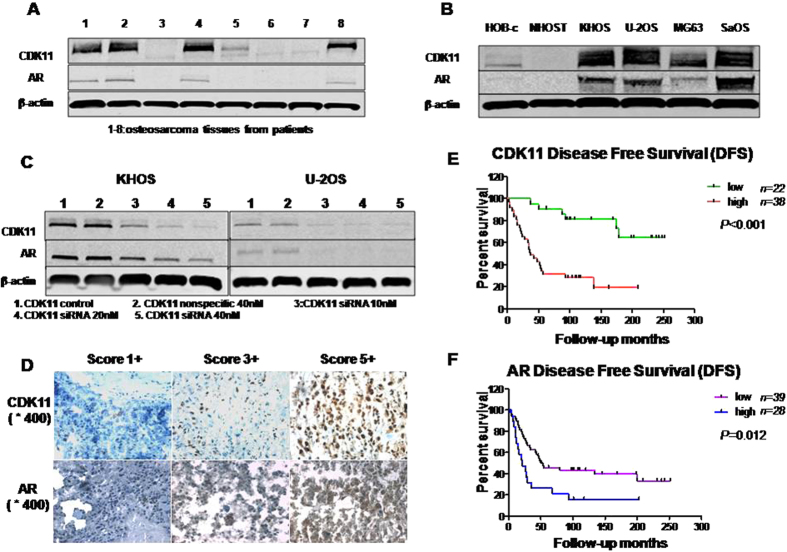
Expression of CDK11 and AR in osteosarcoma cell lines and osteosarcoma tissues.(A) Expressions of CDK11 and AR in osteosarcoma tissues. (B) Expressions of CDK11 and AR in osteosarcoma cell lines and normal osteoblast cell lines. (C) Expression of AR in osteosarcoma with CDK11 siRNA. (D) Representative images of different immunohistochemical staining intensities of AR and CDK11 are shown in osteosarcoma tissues. The percentage of cells showing positive nuclear staining for AR and CDK11 was calculated by reviewing the entire spot. On the basis of the percentage of cells with positive nuclear staining, the staining patterns were categorized into 6 groups: 0, no nuclear staining; 1, 1+, <10% of cells stained positive; 2, 2+, 10% to 25% positive cells; 3, 3+, 26% to 50% positive cells; 4, 4+, 51% to 75% positive cells; and 5, 5+, >75% positive cells (Original magnification, ×400). (E) Kaplan-Meier survival curve of patients with osteosarcoma were subgrouped as either CDK11 low staining (staining ≤2) or high staining (staining ≥3). (F) Kaplan-Meier disease free survival curve of patients with osteosarcoma were subgrouped as either AR low staining (AR staining ≤2) or high staining (AR staining ≥3).